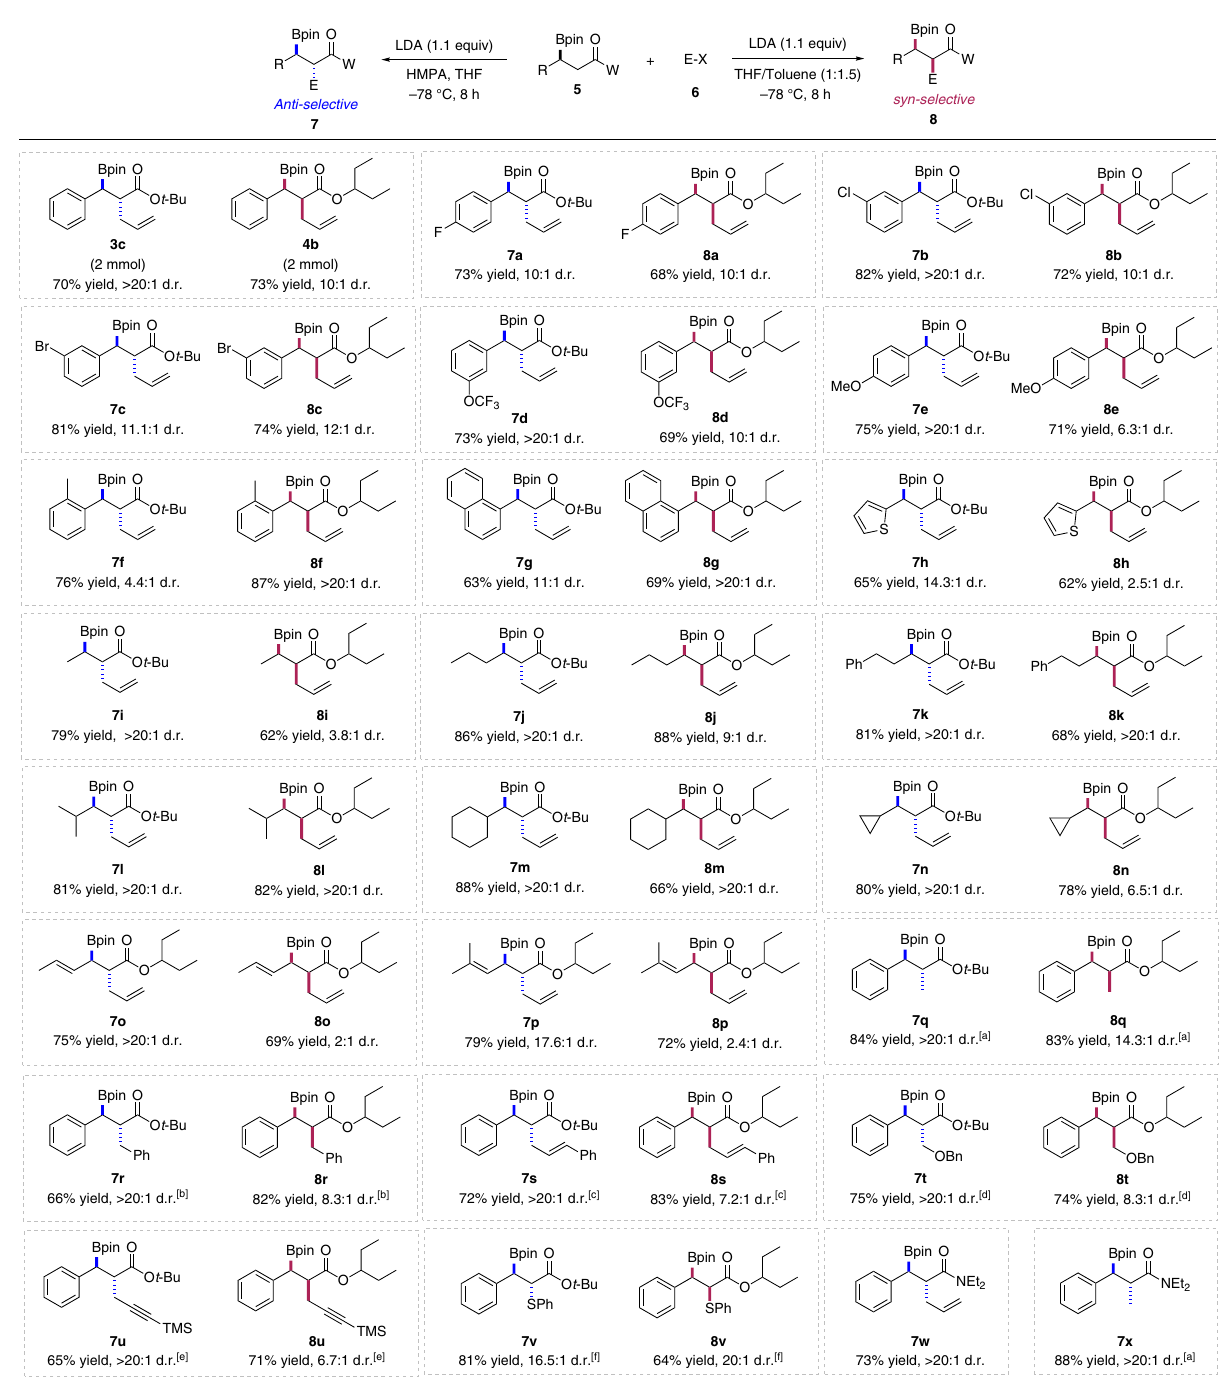
Fig. 2 Substrate scope of the diastereodivergent α -functionalization of β -boronyl carbonyl compounds. Reaction conditions: unless otherwise noted, the reactions were performed at 0.25 mmol scale with 1.5 equiv allyl bromide, 1.1 equiv LDA, and 0.2 mL HMPA (if used). Isolated yields shown. D.r. values determined by 1 H NMR analysis of crude poducts. a Iodomethane as the electrophile. b Benzyl bromide as the electrophile. c Cinnamyl bromide as the electrophile. d Benzylchloromethyl ether as the electrophile. e 3-Bromo-1-(trimethylsilyl)-1-propyne as the electrophile. f Diphenyl disul fi de as the